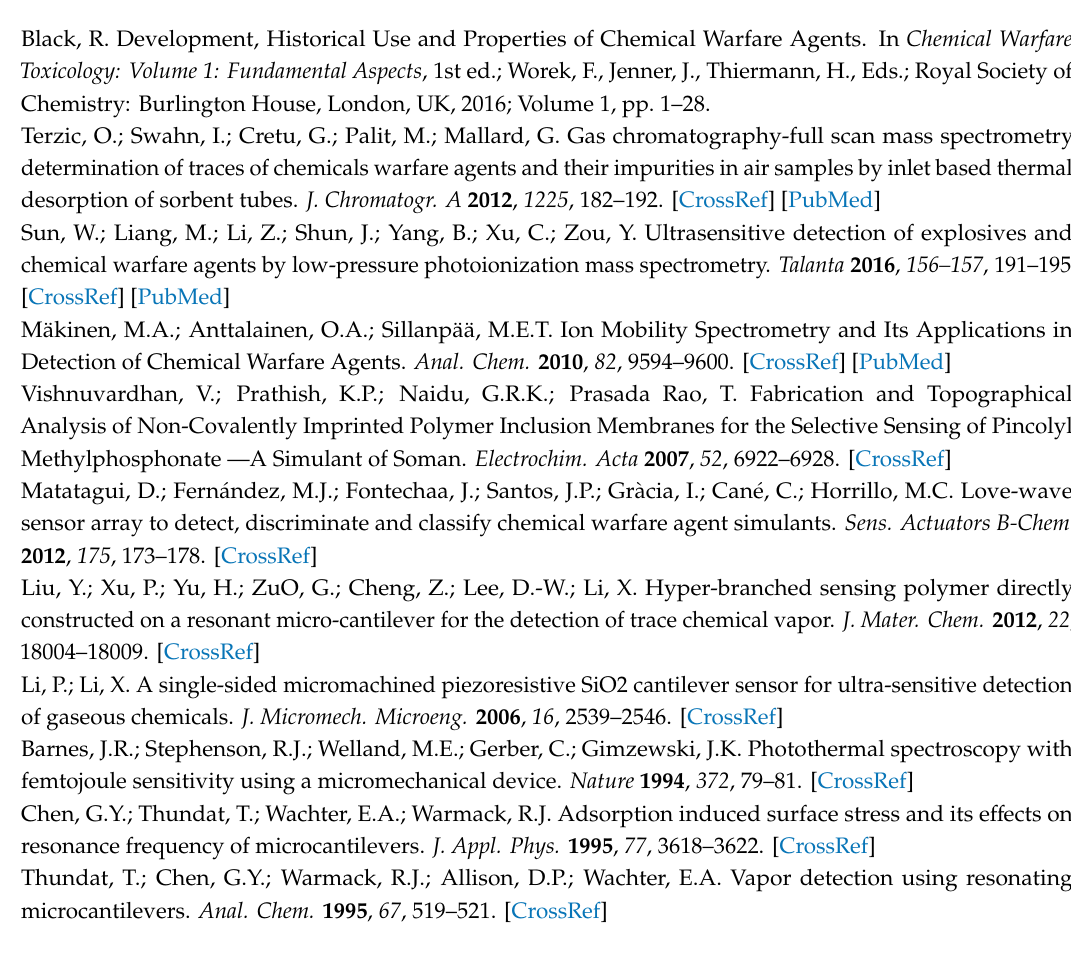
Figure S1: Schematic representation of the protocol used in order to deposit a dense CuO layer on the surface of the cantilever, Figure S2: O1s and Cu2p3 / 2 XPS spectra of the copper layer annealed at 350 ◦ C during one hour under air, Figure S3: SEM top view of a) a raw TL-FM cantilever and b) the same cantilever covered with a CuO layer. The particles visible on picture a) are dust particles present on the cantilever and which were used to adjust the focus on the cantilever